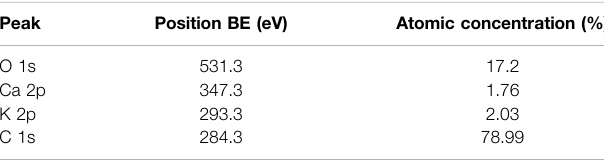
TABLE 1 | Quanti fi ed elemental composition from XPS for AAC800. Peak Position BE (eV) Atomic concentration